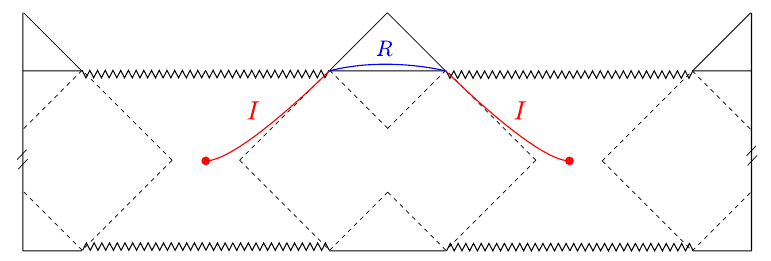
Figure 12. The impure saddle for region R with n = 2